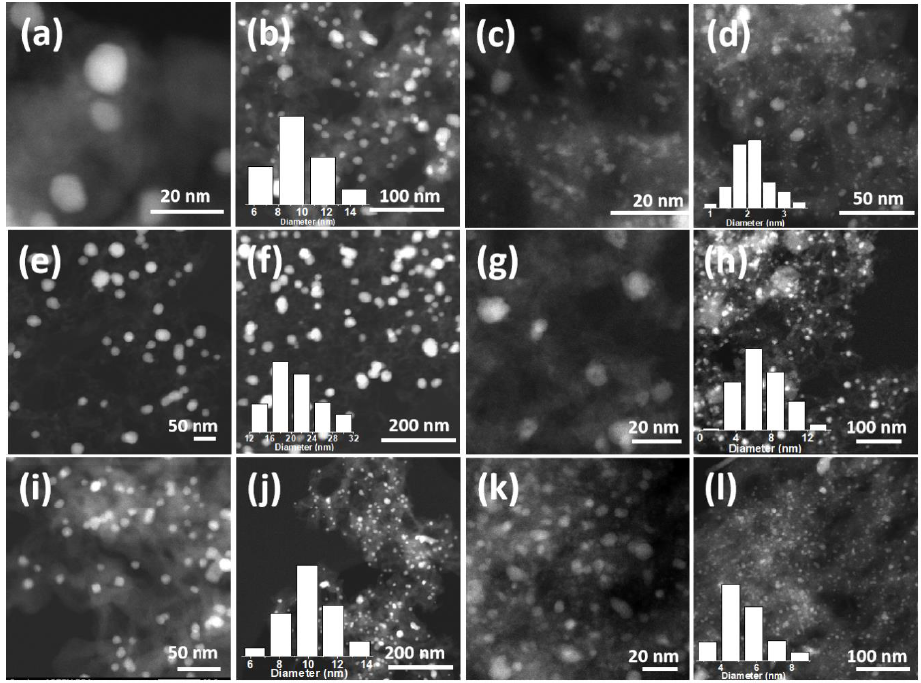
Figure 3. DF-TEM images ( a - l ) of samples 2, 4, 5, 6, 8, 11. ( a , b ): sample 2; ( c , d ): sample 4; ( e , f ): sample 5; ( g , h ): sample 6; ( i , j ): sample 8; ( k , l ): sample 11. Inset: the statistical particle size distributions of samples 2, 4, 5, 6, 8, and 11, respectively.